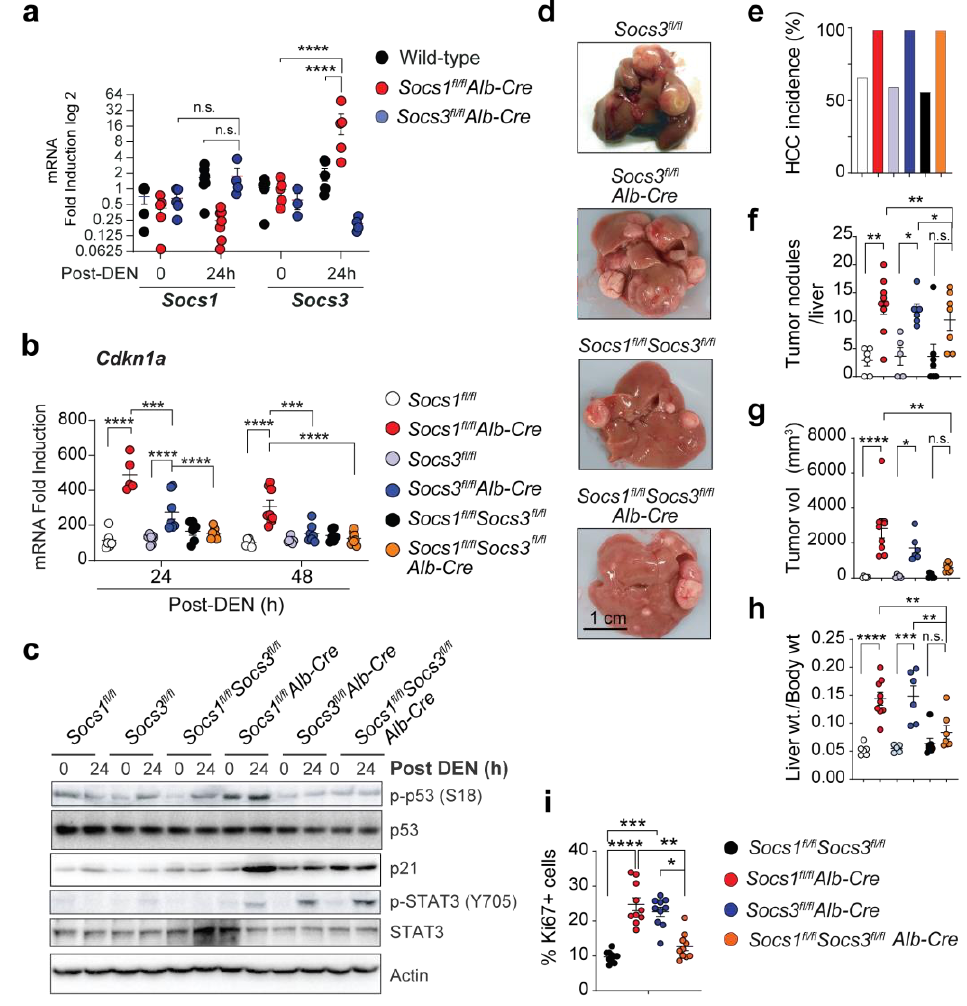
Figure 2. Increased HCC susceptibility of SOCS1-deficient mice requires SOCS3-dependent upregulation of CDKN1A. ( a ) Hepatic Socs1 and Socs3 gene expression in hepatocyte-specific SOCS1- or SOCS3- deficient mice (n = 5 mice/group). ( b ) RT-qPCR evaluation of hepatic Cdkn1a expression in DEN-treated mice (n = 3 – 8/group). ( c ) Immunoblot analysis of phospho-p53, total p53, p21, phospho-STAT3, total STAT3, and α -tubulin in control and DEN-treated mice livers (n > 3). ( d – h ) Two weeks-old mice of the indicated genotypes were treated with DEN (25 mg/Kg body- weight). HCC development was evaluated 10 months later. ( d ) Representative macroscopic liver images (n = 5–9 mice/group). Cumulative data on the incidence rate of HCC ( e ), the number of visible tumor nodules ( f ), tumor volume ( g ) and the liver-to-bodyweight ratio ( h ). To facilitate com- parison, HCC data for Socs1 fl/fl and Socs1 fl/fl Alb-Cre mice are duplicated from ( b – e ). ( i ) Increased cell proliferation within SOCS1 deficient HCC tumor nodules is driven by SOCS3. Proportions of Ki67+ nuclei over Hoechst-stained nuclei (10 randomly selected areas from 3 mice/group) are shown. Mean ± SE; Two-way ( a , b ) or one-way ( f – i ) ANOVA with Tukey’s multiple comparison test; * p < 0.05, ** p < 0.01, *** p < 0.001, **** p < 0.0001; n.s. not